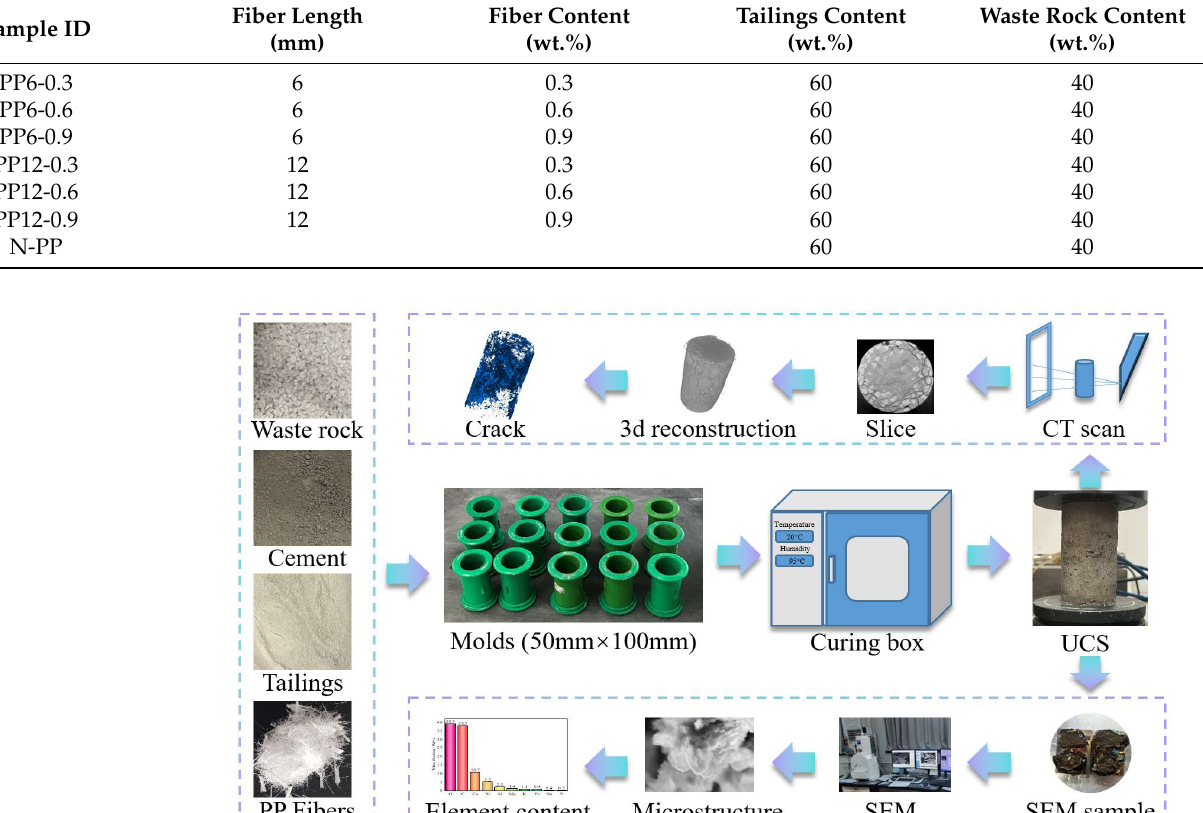
Table 2. The proportions of each component of each specimen.